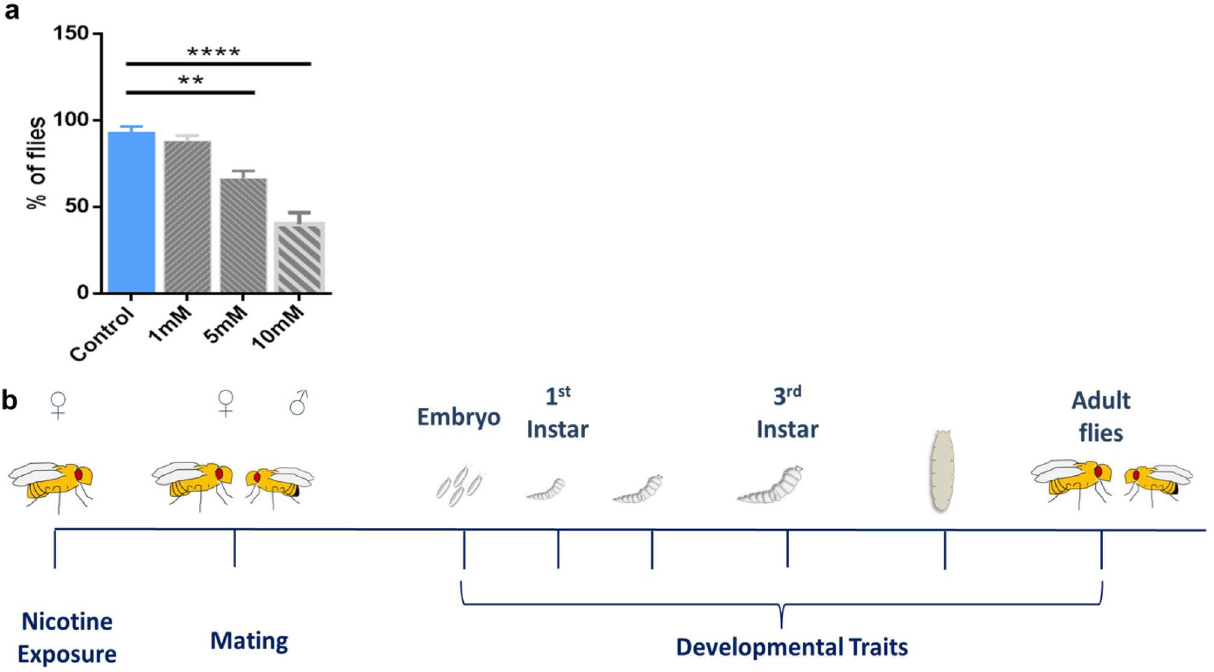
Figure 1. Dose dependent decrease of locomotor activity following e-nicotine exposure. ( a ) The locomotor activity of 10 flies/group vs time. The number (percentage) of flies that reached a height of 7 cm in 10 s following the exposure to different concentrations of nicotine as compared to the water-exposed controls was recorded ( b ) Experimental outline, female flies were exposed to 5 mM of volatilized nicotine for 8 times once per an hour, thereafter, the flies were mated with the males of the same age and their offspring were analysed across the timeline. Values are mean ± SEM, one-way ANOVA, **p ≤ 0.01, ****p ≤ 0.0001, n = 3 independent